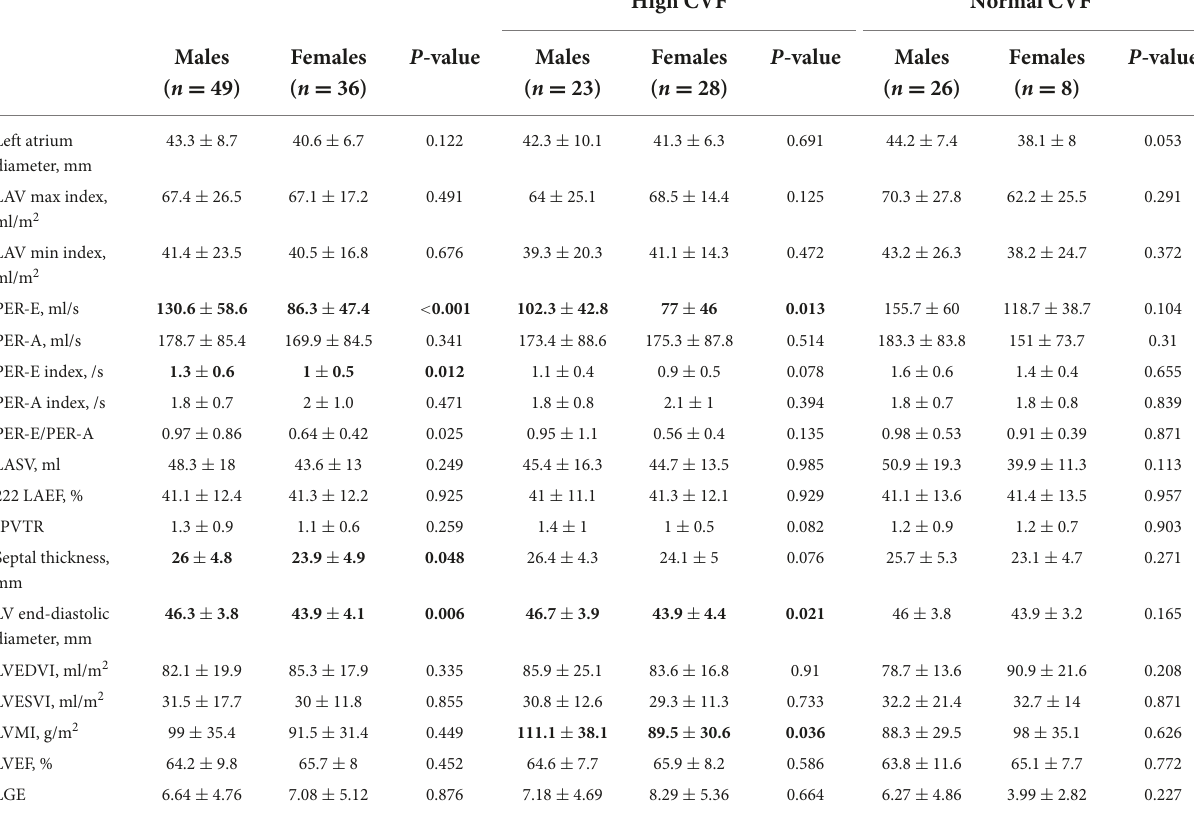
TABLE 2 Cardiac magnetic resonance (CMR) parameters in patients with hypertrophic obstructive cardiomyopathy